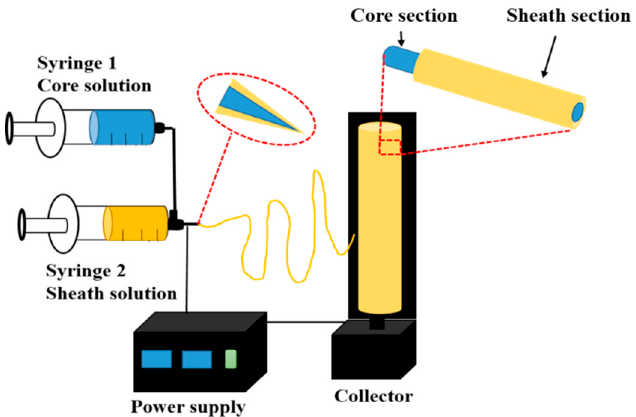
Figure 3. Schematic diagram showing the coaxial electrospinning system.